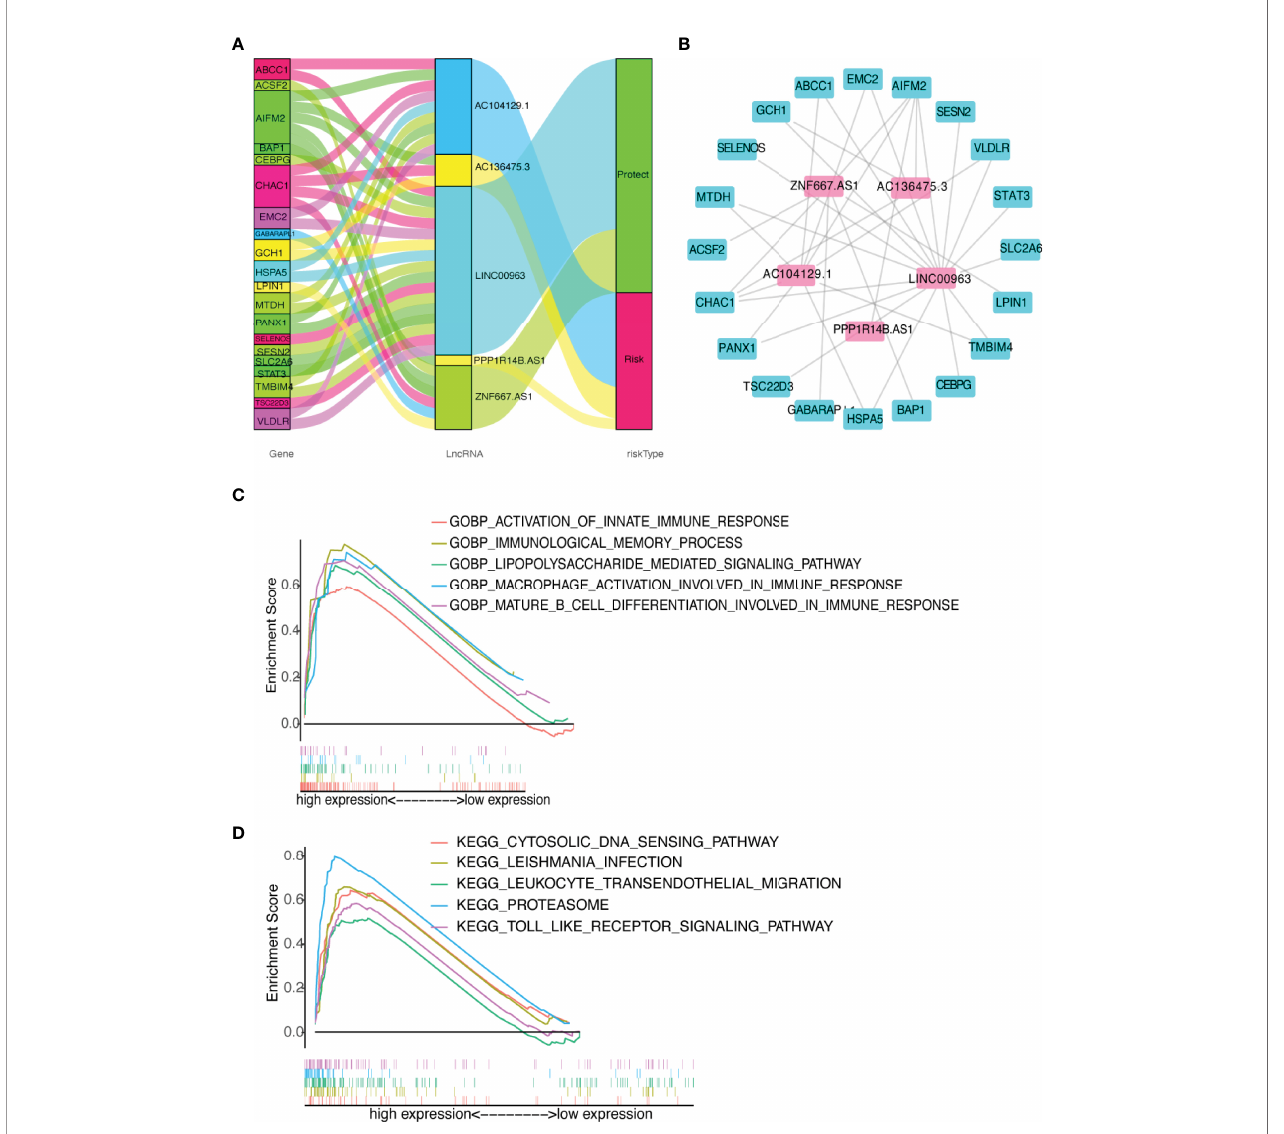
FIGURE 8 | Diagram of lncRNA-mRNA coexpression network and functional analysis. (A, B) Alluvial diagram of the relationship between lncRNA and co-expression mRNA with different risk-subgroups. (C) GO function annotation of different risk groups. (D) The signi fi cantly enriched KEGG pathways by GSEA using immune gene